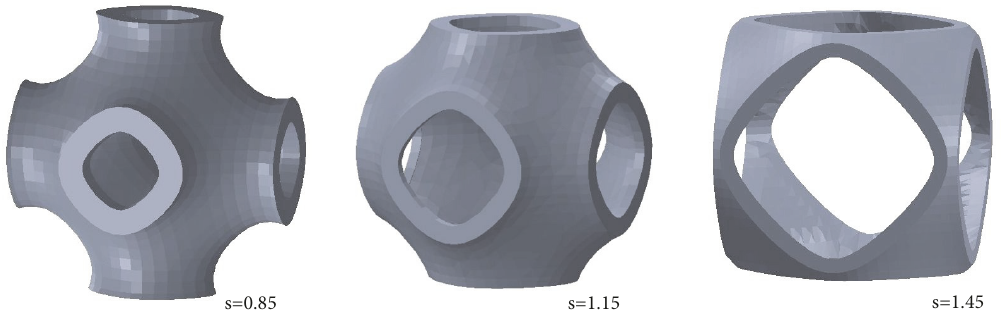
Figure 16: Architectures of solid P-cells with different values of the parameter s and 𝑘 = 0 .